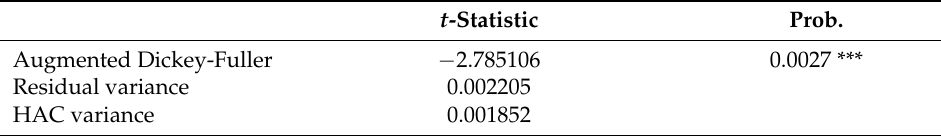
Table 5. Co-integration test.